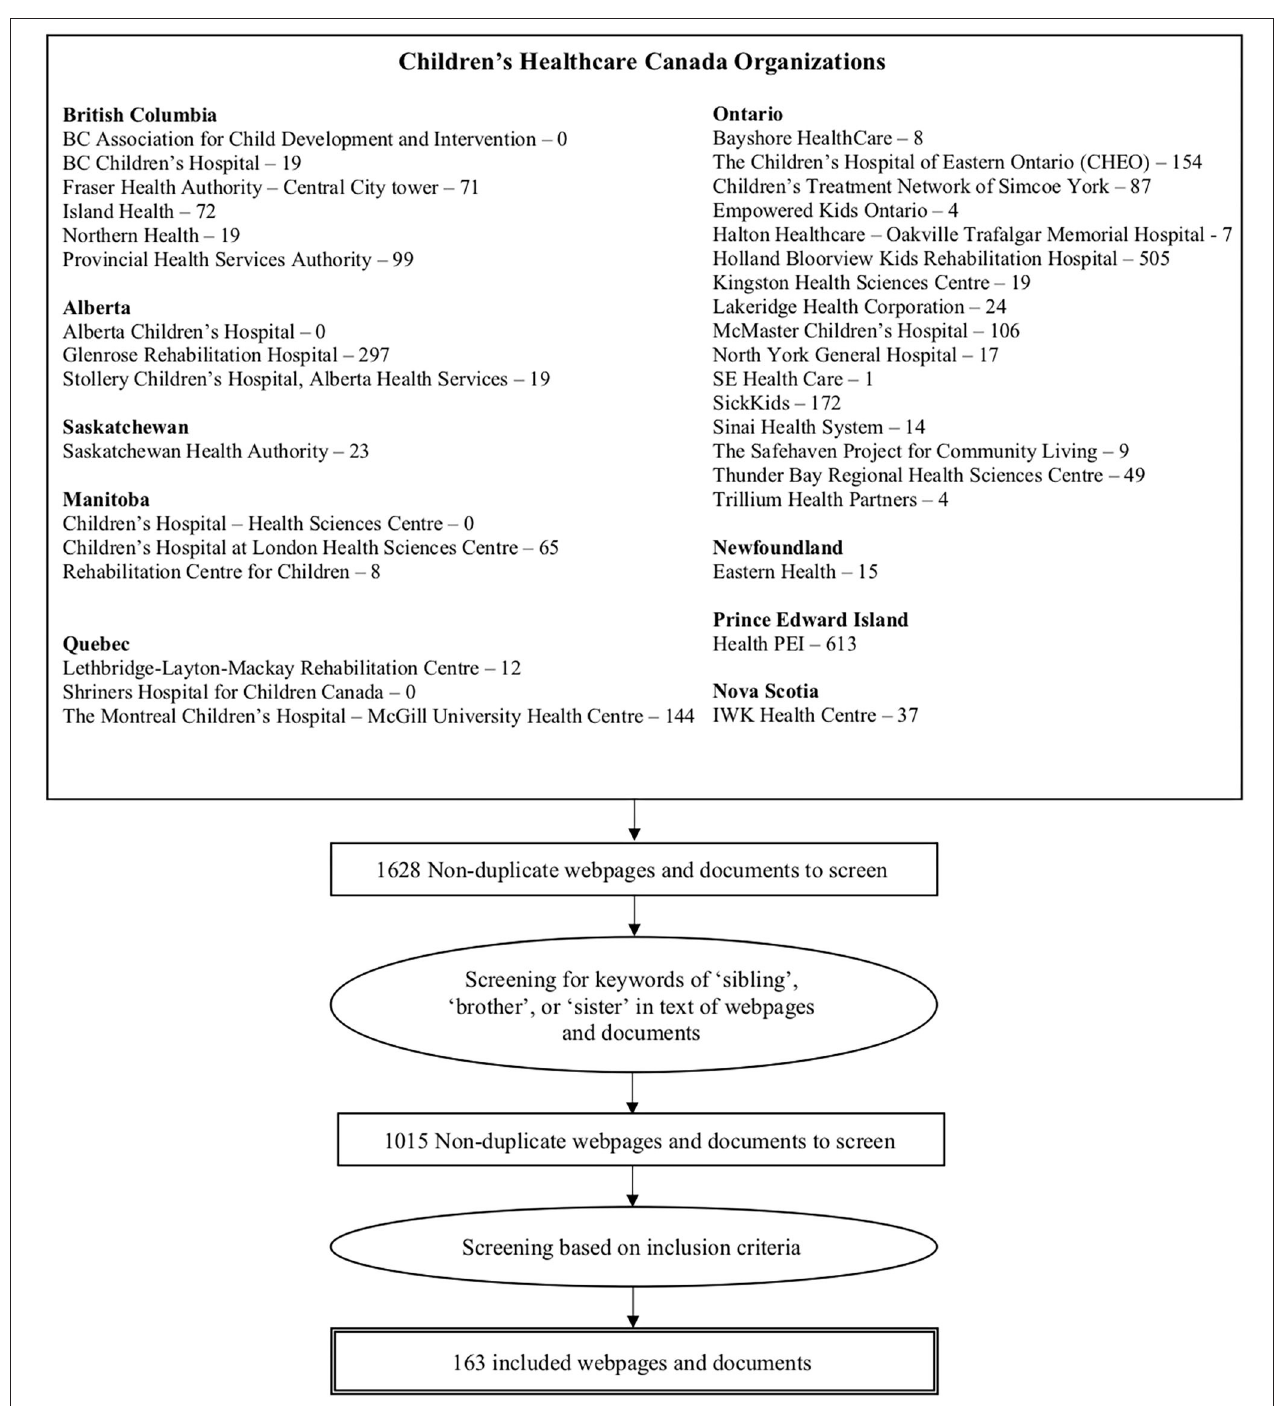
FIGURE 1 | Flow diagram outlining the section of included websites and documents.